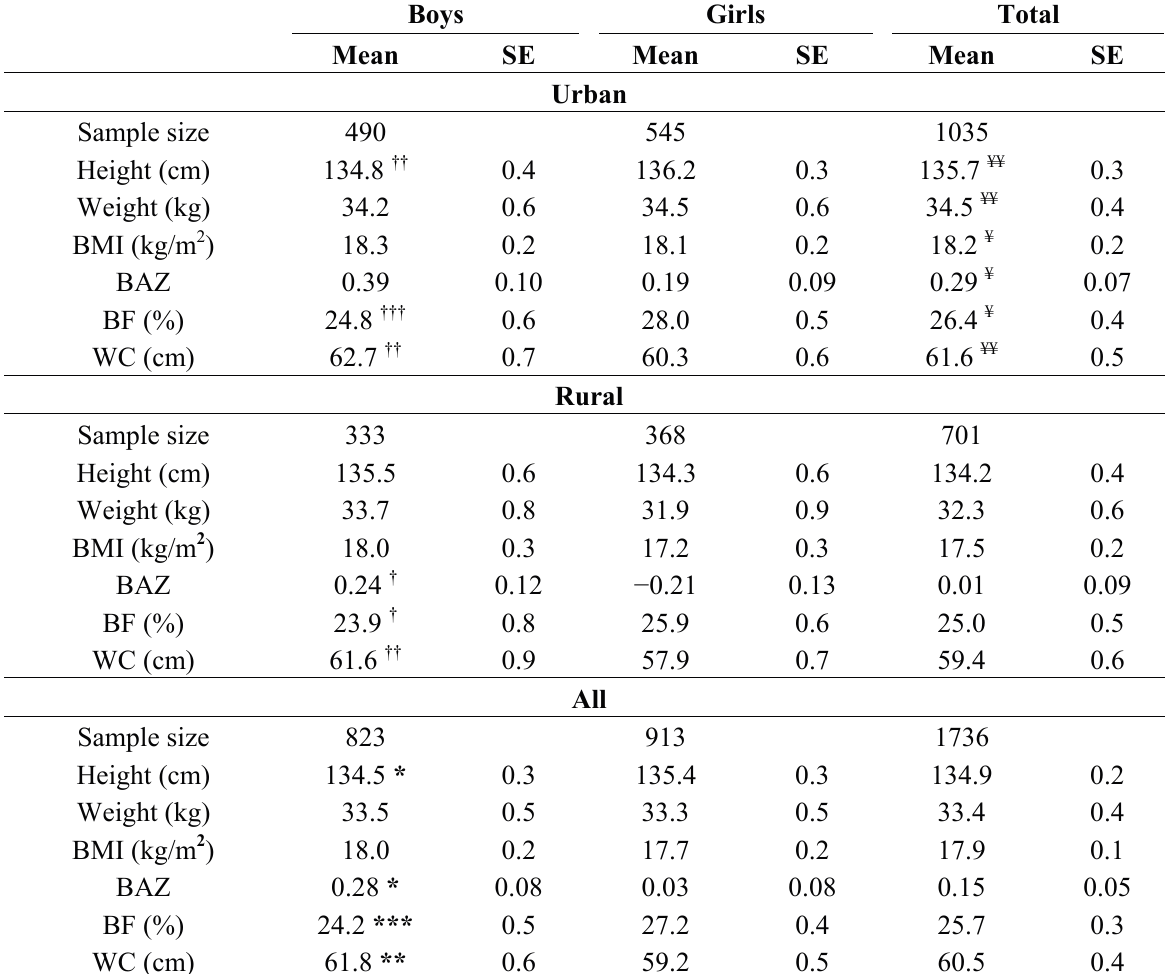
Table 2. Nutritional status of children by sex and area of